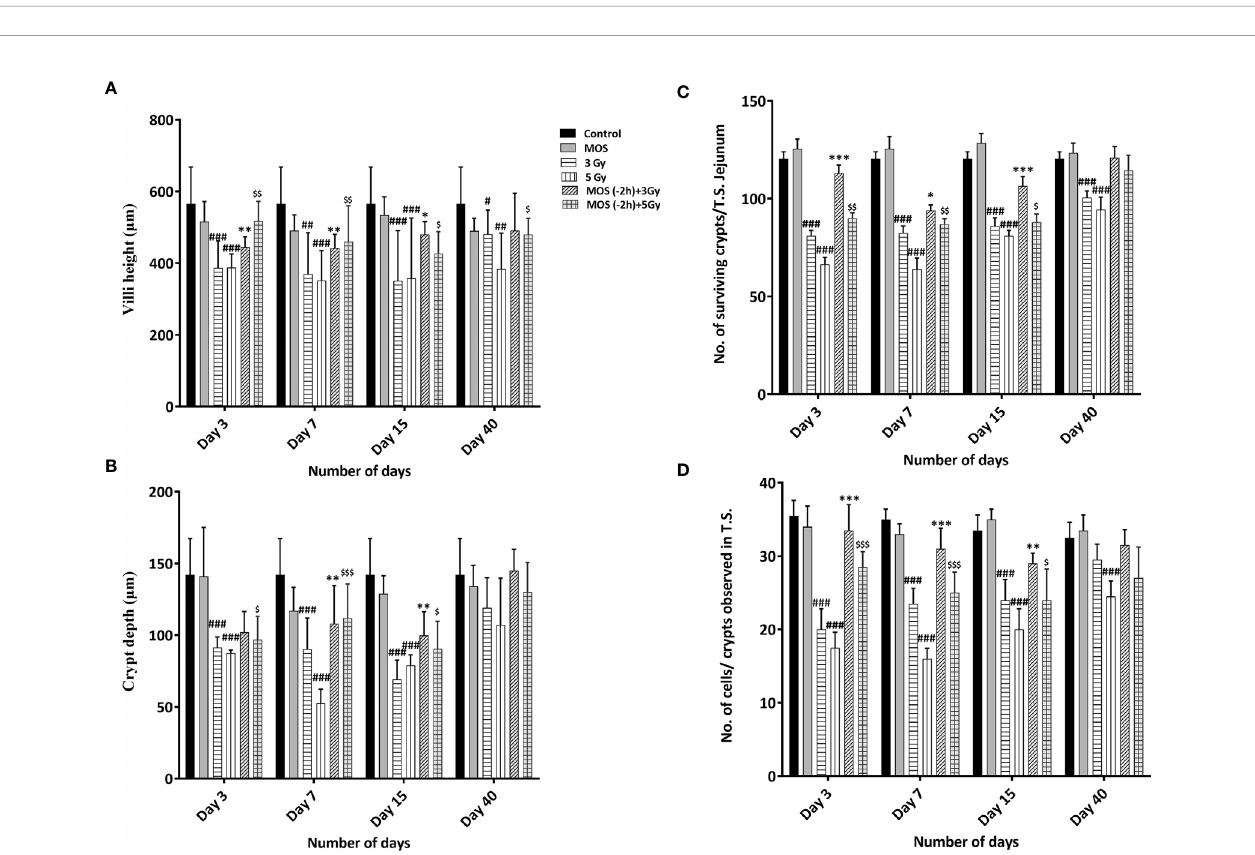
FIGURE 5 | (A – D) Histological examination of small intestine: Mice were treated with MOS (200 mg/kg bw) and/or subjected TBI (3 Gy and 5 Gy) and thereafter assessed for histological examinations of small intestine on days 3, 7, 15 and 40-post MOS treatment and/or TBI as described in materials and methods. Representation of (A) Villi height (mm) (B) Crypt depth (mm) (C) No. of surviving crypts/T.S. Jejunum (D) No. of cells present per crypt observed in T.S. Error bars represent mean ± SD, and * p < 0.05, ** p < 0.01, *** p < 0.001, # p < 0.05, ## p < 0.01, and ### p < 0.001 , $ p < 0.05, $$ p < 0.01 and $$$ p < 0.001 were considered signi fi cant, # compared to unirradiated control, *compared to 3 Gy irradiated cohorts and $ compared to 5 Gy irradiated cohorts.